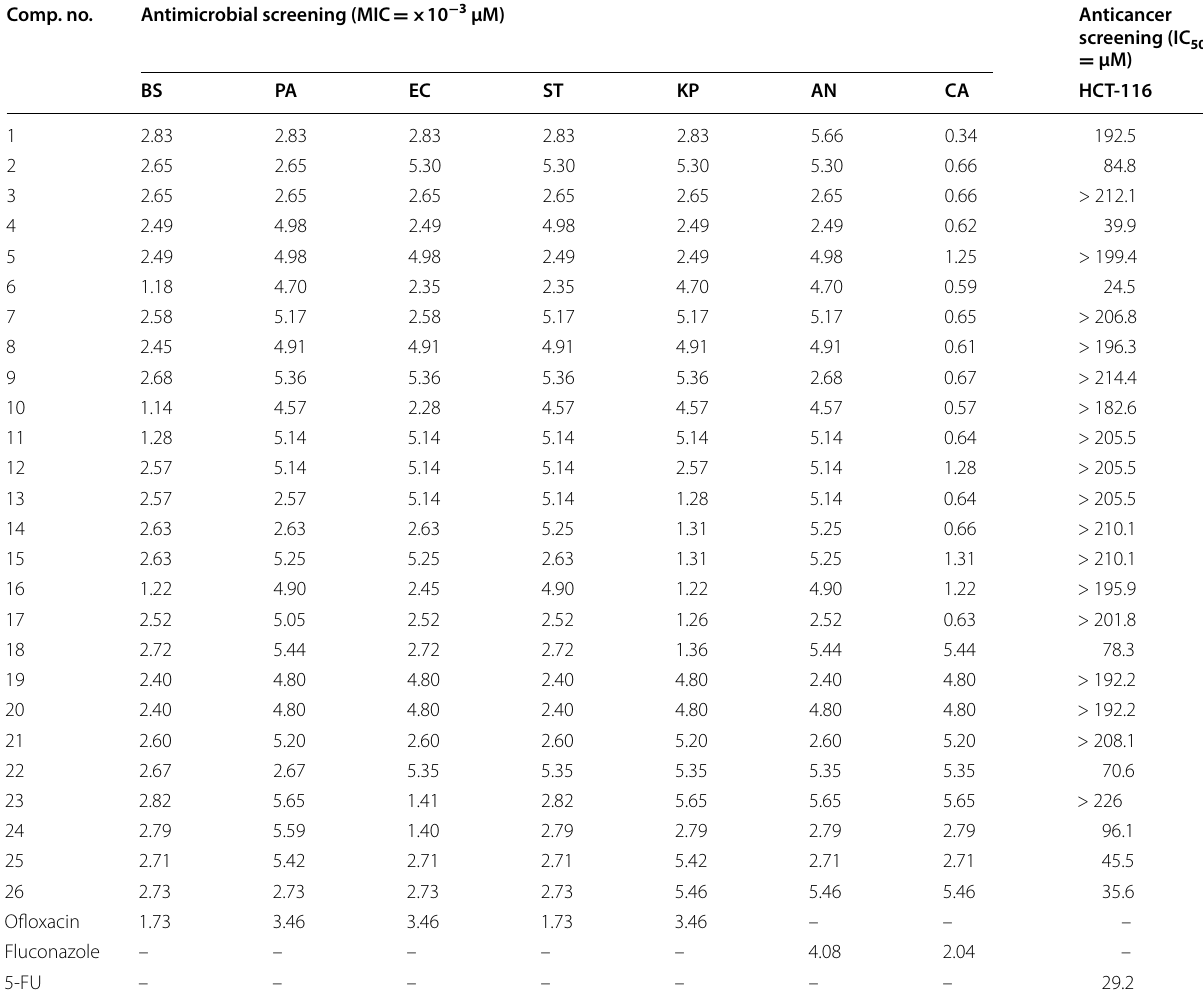
Table 2 In vitro antimicrobial and anticancer screening of the synthesized derivatives (1–26) Comp. no.